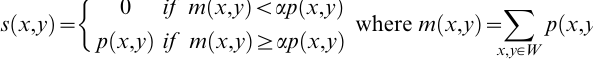
Figure 4. Qualities of Caspase stained cells identified and counted by DeadEasy. (A) Images showing a 3D rendering of the whole stack stained with Caspase, a single 0.25 m m section from this stack and the same section after object recognition by DeadEasy. (B) Enlarged image to show what Caspase stained cells look like, revealing the characteristic amorphous shape, low signal intensity and high background resulting from these antibodies. The accurate cellular parameters are given in Table 1. (C) User-friendly pop-window prompted by the programme to enable the user to modify the parameters easily, following the guidelines indicated in Table